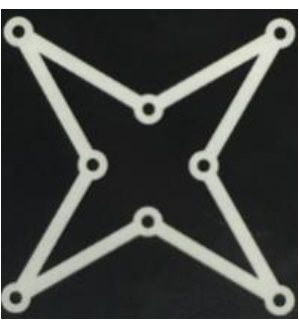
Figure 2. Printed mask.